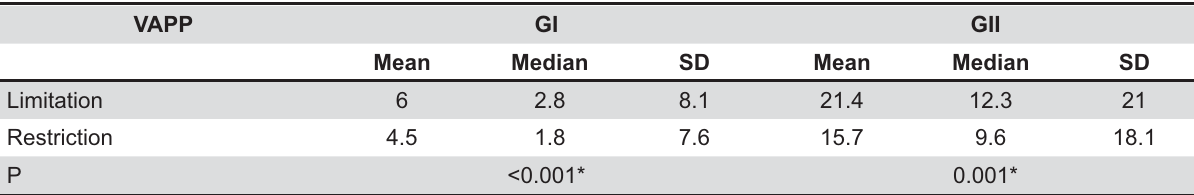
SD=Standard Deviation